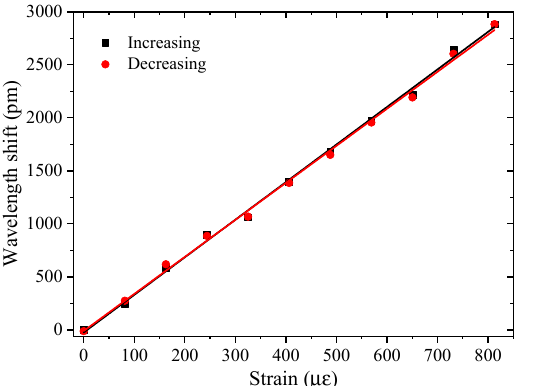
Figure 2. Wavelength shift of the FPI with applied strain. The black and red solid lines represent the linear fits of the increasing and decreasing elongations, respectively.